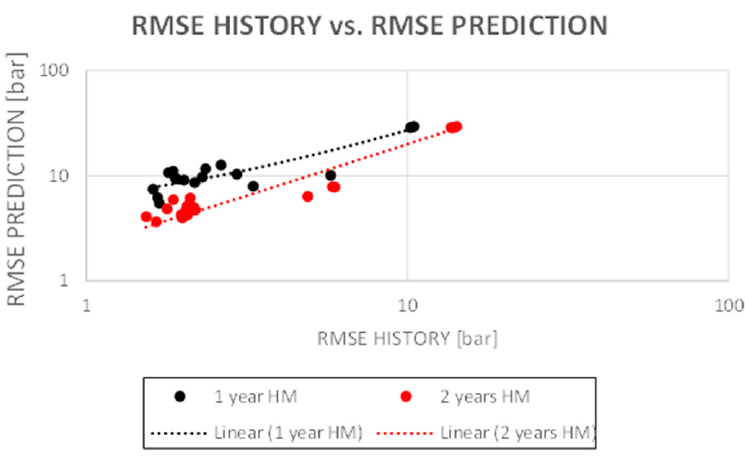
Figure 6. The relationship between the quality of history-matching and predictiveness of the models.